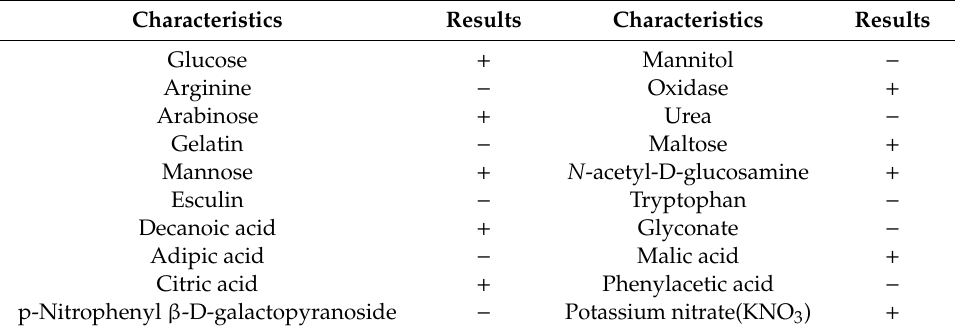
Table 1. Physio-biochemical properties of strain SH14 (API 20 NE identification